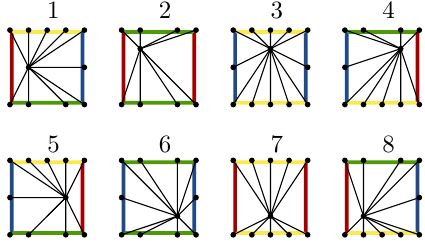
Figure 8. Mutually edge-compatible finite element meshes on